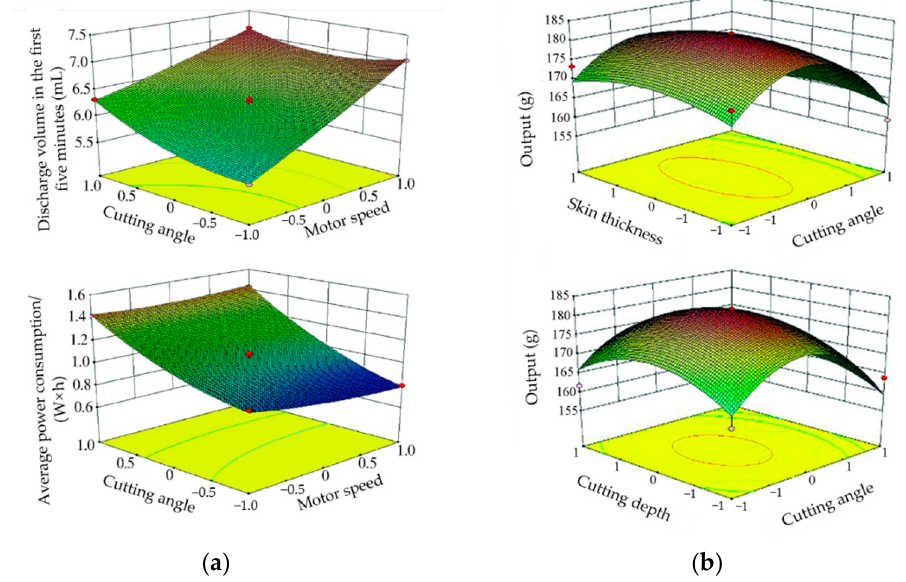
Figure 8. Diagram of experiment results. The change in the color of the graph from blue to red indicates the change in the ordinate from less to more. ( a ) Interaction response surface [59]; ( b ) response surface diagram of cutting angle and cutting depth (left), and response surface diagram of cutting angle and bark consumption thickness (right) [58].